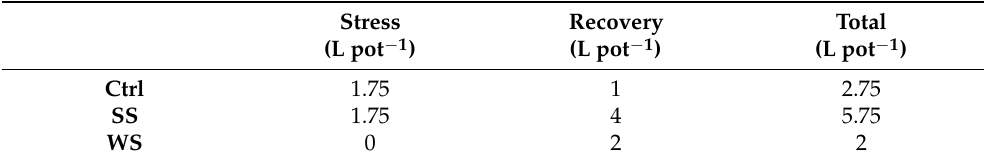
Table 3. Amount of water distributed per pot during the stress period (Stress) and the recovery period (Recovery) in the three treatments (Ctrl, control; SS, irrigation with 700 mM NaCl; WS, complete withholding of